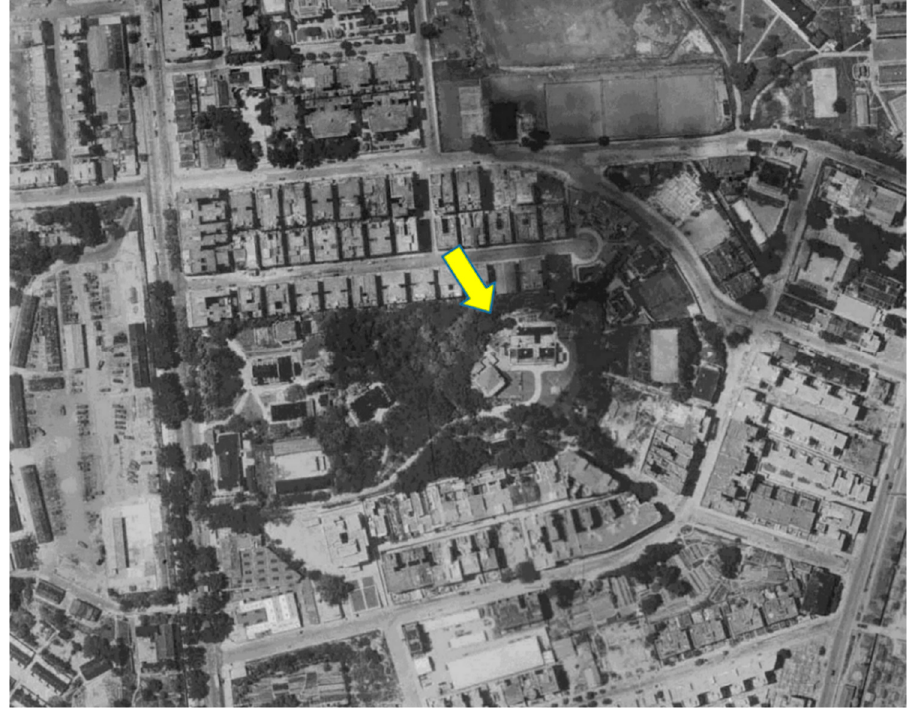
Figure 7. Buildings surrounding the HKO headquarters in May 1949. The yellow arrow indicates the location of the Hong Kong Observatory, the same below.